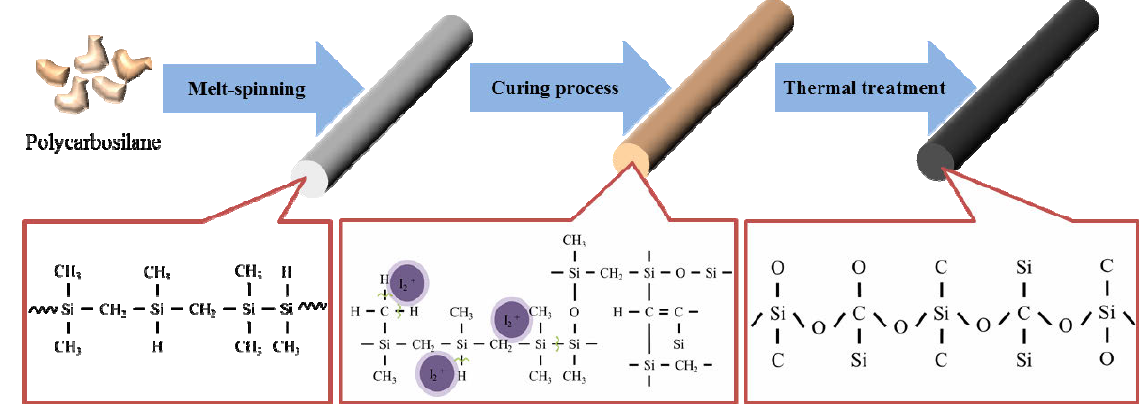
Fig. 3 Schematic illustration of conversion process for PCS to SiC fiber.